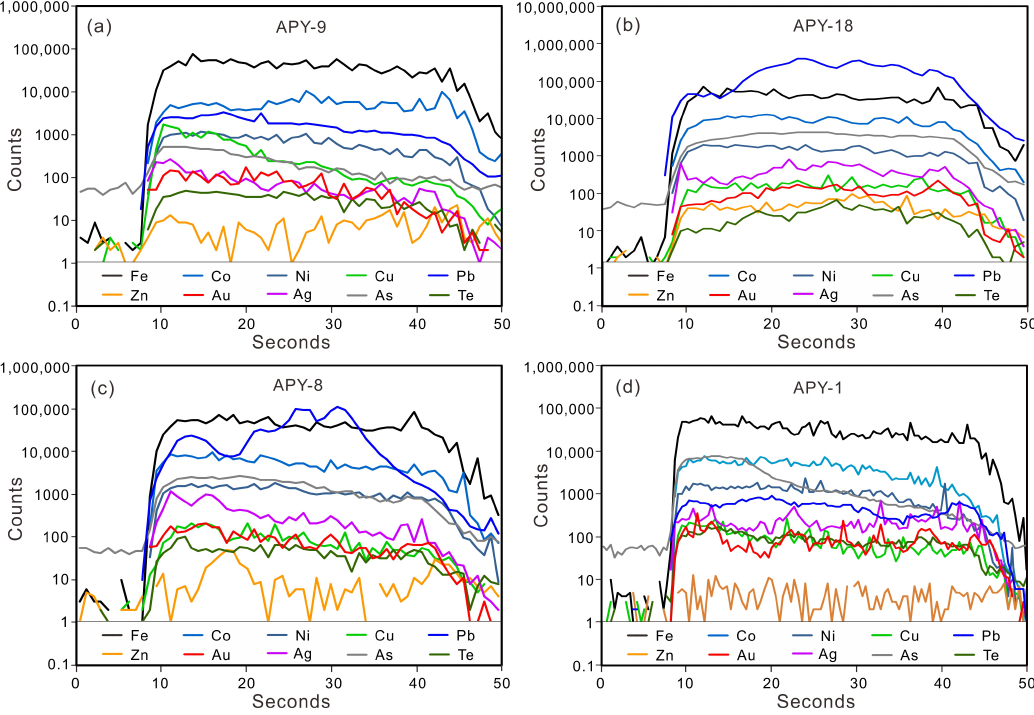
Figure 5. LA-ICP-MS time-resolved depth profiles for Py1 from selected samples showing the occurrences of Au and other elements. The smooth time-resolved depth profiles for Au and Ag ( a – c ) reflect solid-solution gold and electrum in Py1. The spiky time-resolved depth profiles for Au, Ag, and Te ( d ) suggest that some Py1 grains contain small amounts of native Au, electrum, and/or Au-Ag-Te minerals as nano- to submicron-sized inclusions.